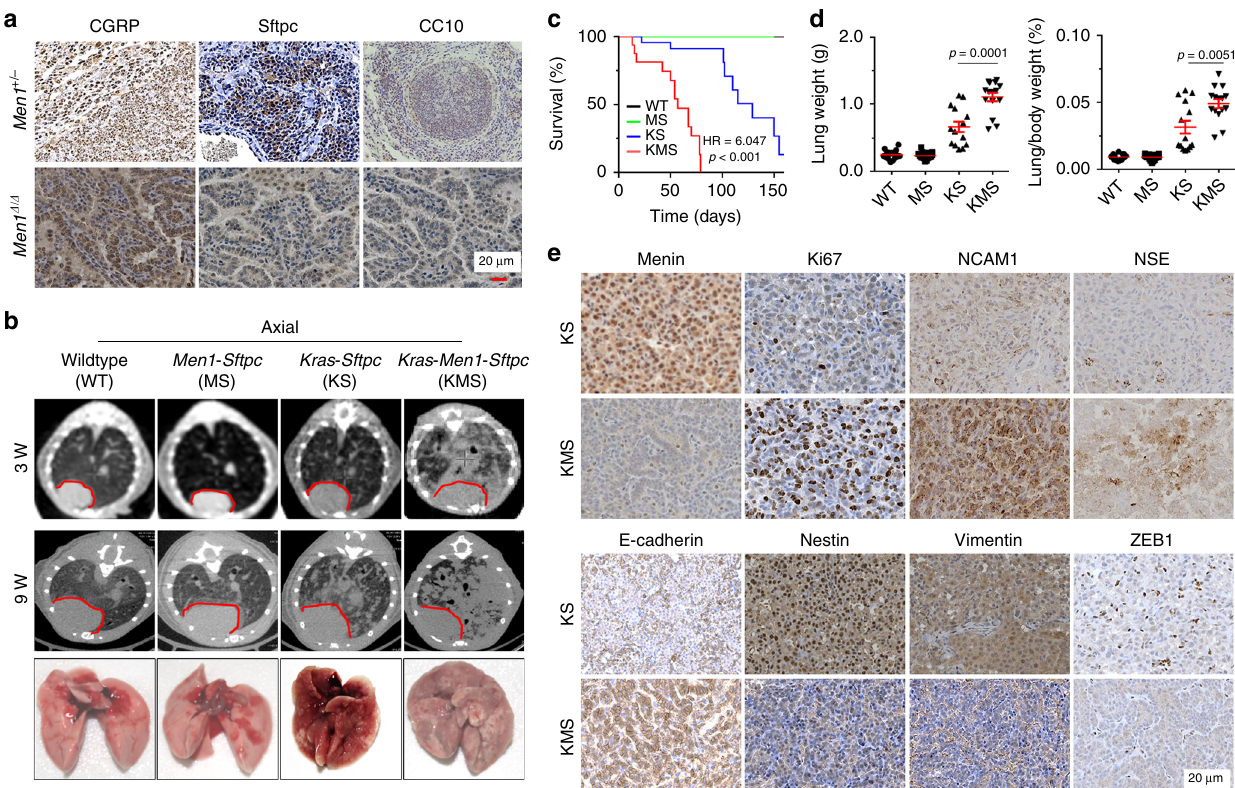
Fig. 2 Men1 de fi ciency accelerates the development of Kras -induced lung cancer. a IHC staining was performed with the indicated speci fi c markers in lung tumors from Men1 + / − and Men1 Δ / Δ mice (from Fig. 1). CGRP, NE cells; Sftpc, ATII cells; CC10, Clara cells. Scale bars, 20 μ m. b Representative axial thoracic microCT images from mice of the indicated genotypes at 3 and 9 weeks after i.p. injection of TAM. The red line marks the location of the pericardium. The bright fi eld images show lung tissues from mice of the indicated genotypes at 9 weeks. c Kaplan-Meier survival analysis of mice of the indicated genotypes (WT: n = 17; MS: n = 15; KS: n = 14; KMS: n = 16). d Scatter plot of lung weight and lung weight/body weight of the indicated mice at 9 weeks (WT: n = 17; MS: n = 15; KS: n = 14; KMS: n = 15). e IHC staining for the indicated proteins in the lung tumors of KS and KMS mice at 9 weeks. Scale bars, 20 μ m. Data are represented as mean ± SEM in d . Dots in d depict individual samples. The hazard ratios (HR) and p values by log-rank (Mantel- Cox) test are indicated in c . KS mice compared with KMS mice, p < 0.0001. Signi fi cance determined by two-tailed unpaired t tests are indicated in d . Source Data are provided as a Source Data fi